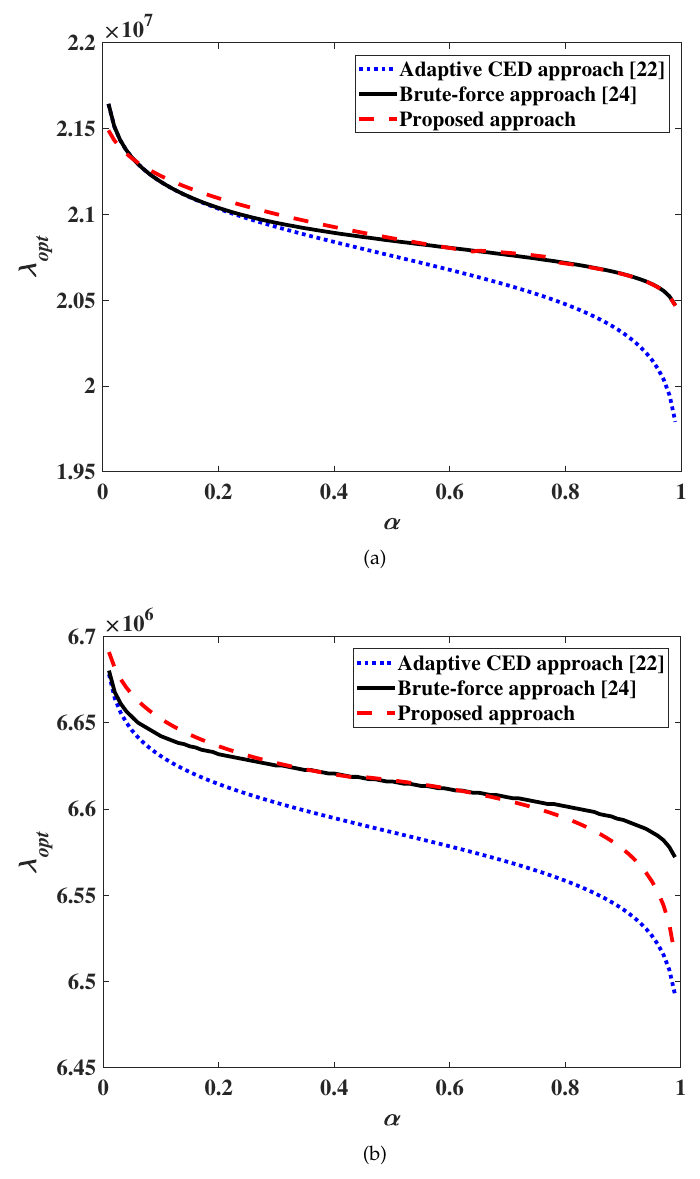
Figure 1. Optimum threshold as a function of α . ( a ) SNR γ = − 25 dB, ( b ) SNR γ = − 20